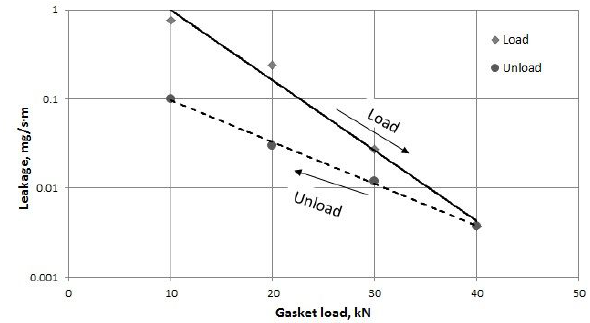
Figure 18: Tightness characteristic of the optimal gasket